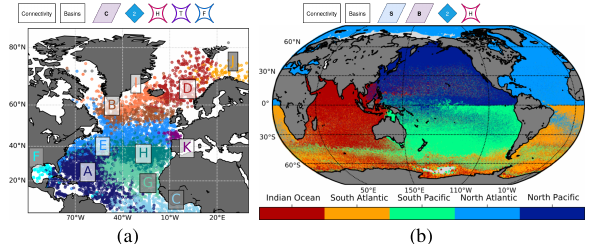
Figure 3. Particle densities. a) (Van Sebille et al., 2012), fig. 1 (adapted), monochromatic saturation and significant-value dark contour highlight. b) (Wichmann et al., 2019a), fig. 1 (adapted), hues and brightness.